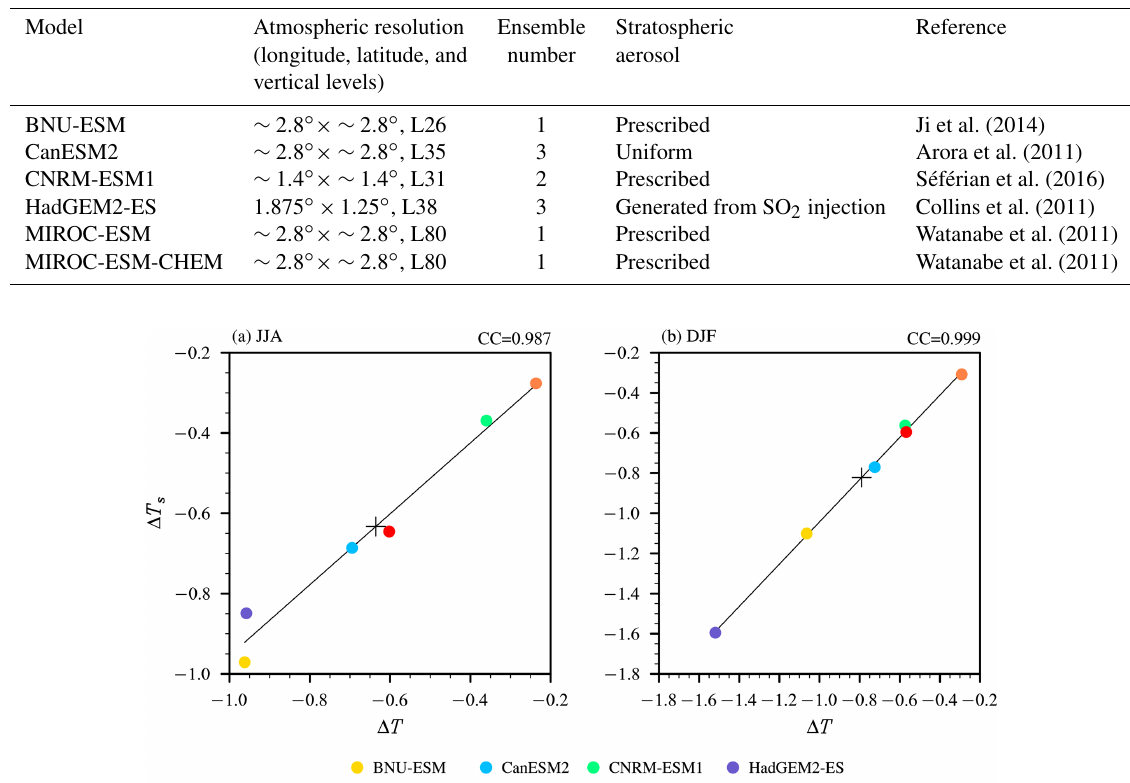
Table 1. Main features of climate models used in this study.